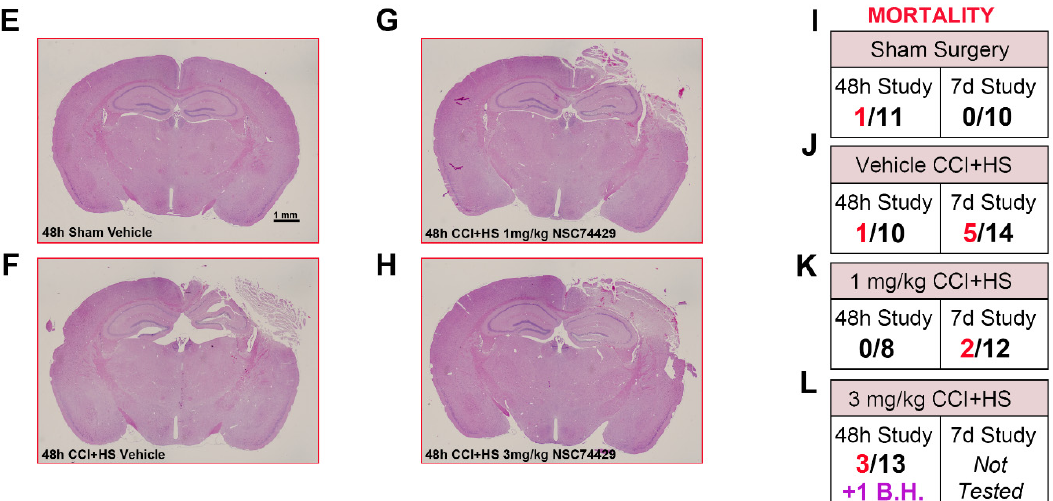
Figure 4. Evaluation of NSC74429 Mediated Neuroprotection in a Mouse Model of TBI. ( A , B ) Scatter plots of normalized CA1 and CA3 cell counts at 48 h post-injury. ( C , D ) Scatter plots of normalized CA1 and CA3 cell counts at 7 d post-injury. Individual data points highlighted in red in the scatter plot correspond to the mouse brains selected as representative images in panels E-H. ( E – H ) Representative images of H&E-stained brains used to assess CA1/CA3 cell loss. ( I – L ) Mortality for each group by treatment and study endpoint. Asterisks indicate significance compared to vehicle-injured rats. The red text indicates animals that died. The purple text indicates an animal that survived to the study endpoint but had bleeding in the brain that precluded cell counting. Data were significant at p < 0.05. Not Significant (N.S.), Brain Hemorrhage (B.H.), Controlled Cortical Impact (CCI), Hemorrhagic Shock (HS). (*) = p < 0.05, (**) = p < 0.01, (****) = p < 0.0001.